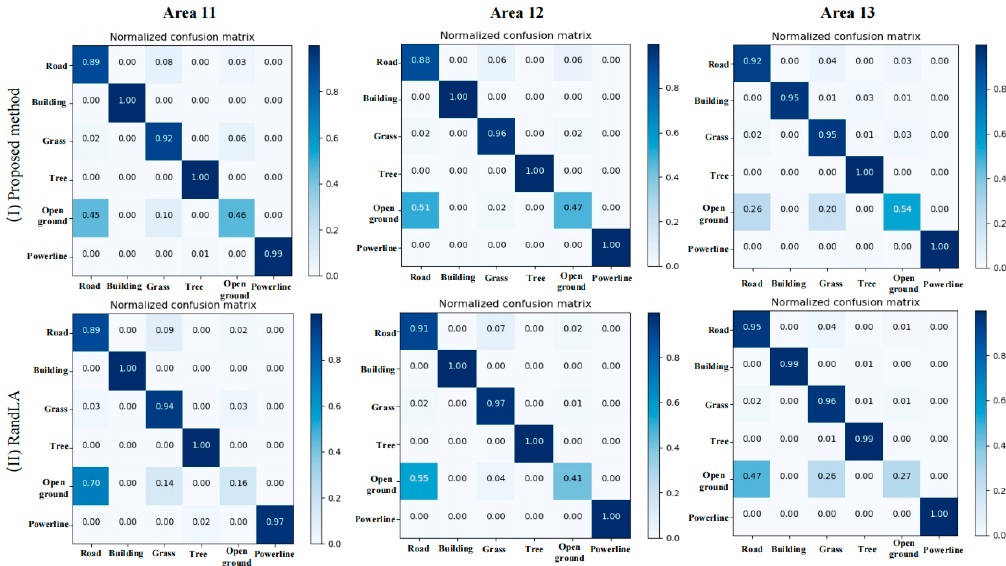
Figure 11. The confusion matrix of the original RandLA and the proposed method in this paper.